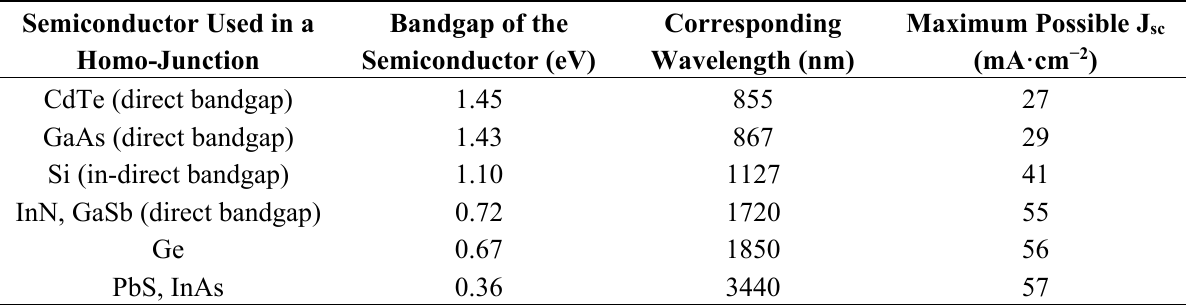
Table 1. Maximum possible J sc from ideal homo-junctions based on different semiconductors when there are no losses within the device. These maximum J sc values are obtained from the theoretically calculated graph shown in Figure